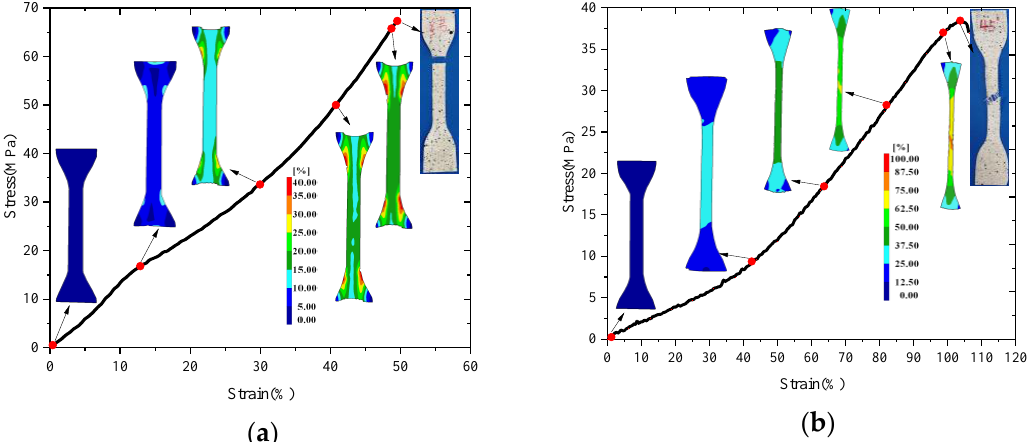
Figure 5. Experimental results of PVC membrane under uniaxial tension: ( a ) fiber direction tension, ( b ) tensile force 45 degrees from fiber